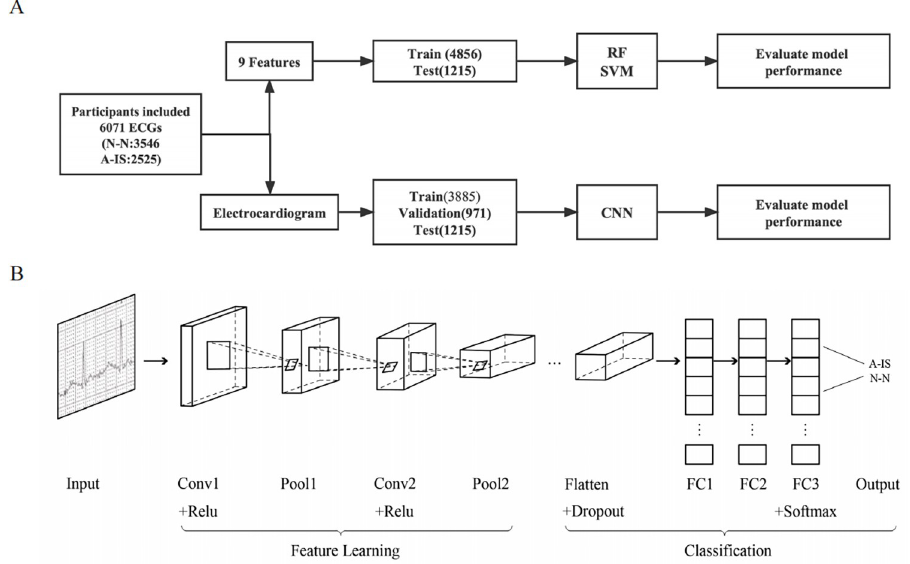
Fig 1. Pipeline of AI model development and CNN structure. (A) Overview of the pipeline of AI model construction. A total of 6071 ECGs from the primary cohort were included, and we trained the ML models with the following demographics and ECG parameters: sex, age, heart rate (bpm), P wave (ms), P-R interval (ms), QRS wave (ms), QT interval (ms), QTc interval (ms), and RV5+SV1 (mV). The CNN model was developed using the training and validation datasets as input. After building the model, the test dataset was used to evaluate the final model performance. (B) The structure of the CNN model, including 2 convolution layers (Conv), 2 pooling layers, and 3 fully connected layers (FC). Note: A-IS indicates abnormal ECG after the first ischemic stroke; N-N, normal ECG; RF, random forest; SVM, support vector machine; CNN, convolutional neural network; Conv, convolution layers; Relu, rectified linear unit; FC, fully connected